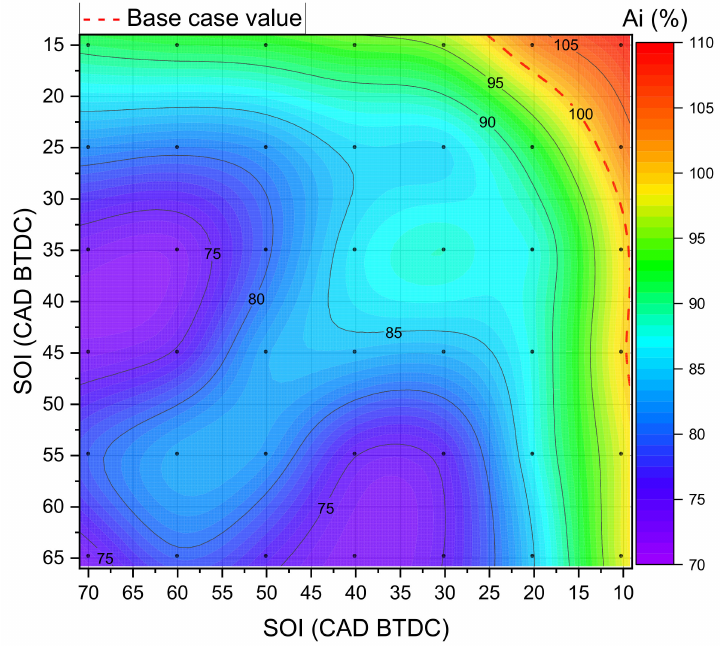
Figure 9. Indicated work contour